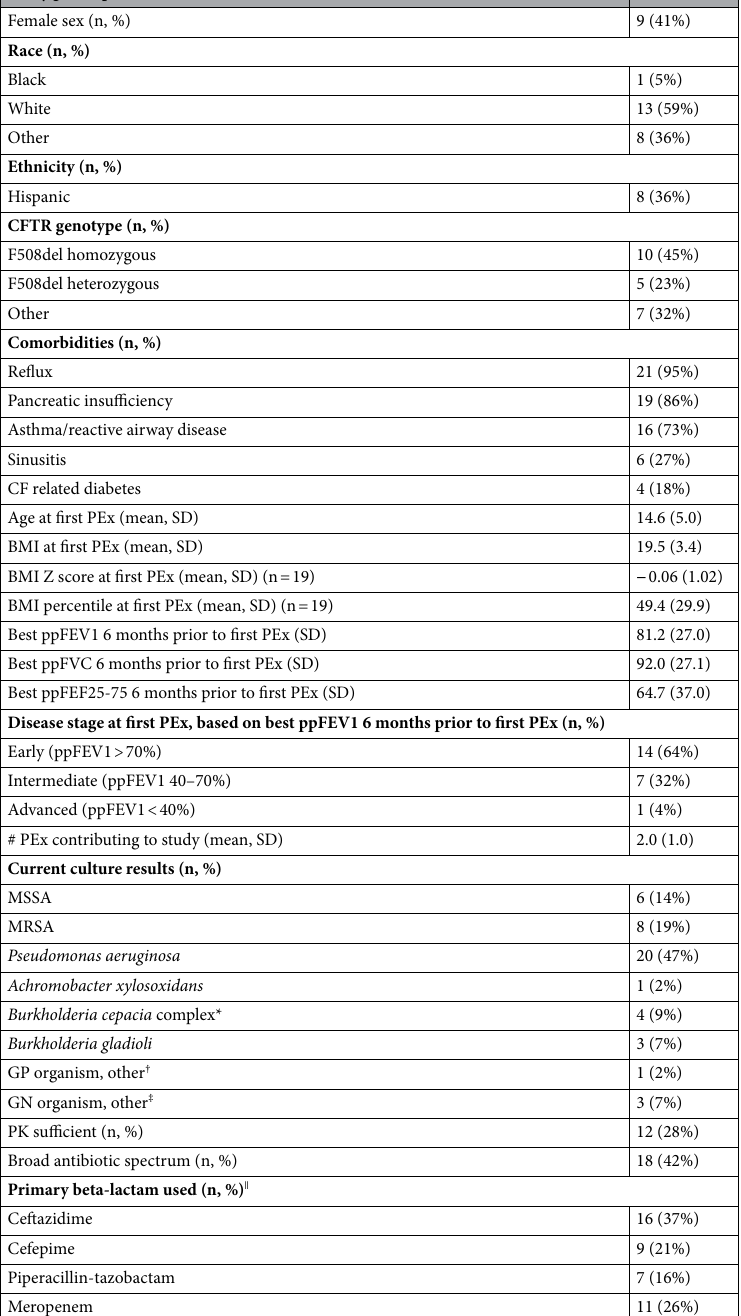
Table 1. Demographics and clinical characteristics of study cohort. * B. cepacia complex = 3 B. cepacia , 1 B. multivorans. † GP, other = Streptococcus pyogenes. ‡ GN, other = Acinetobacter baumanii (n = 1),